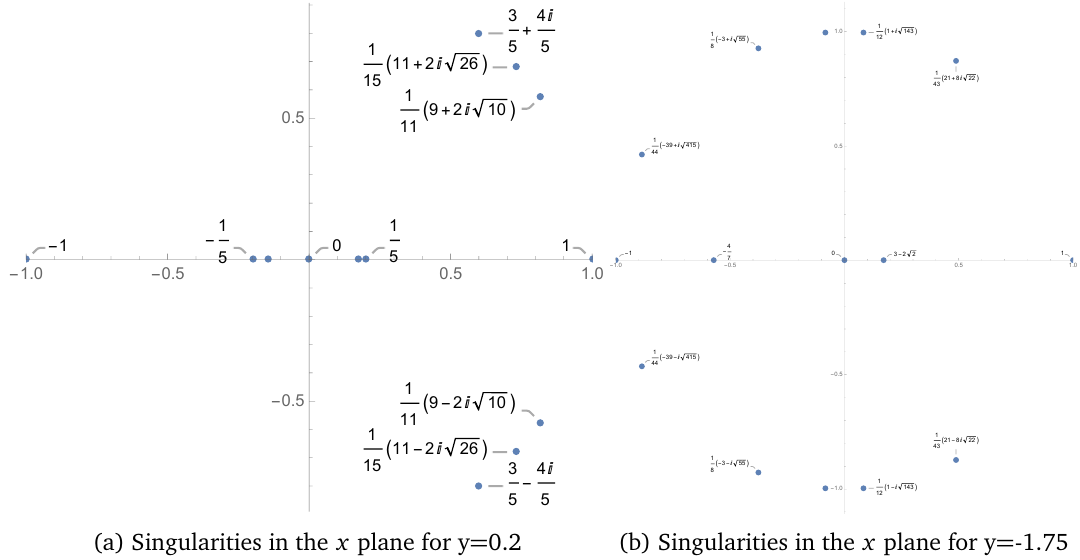
(b) Singularities in the x plane for y = -1.75 Figure 4: Singularities of the differential system of